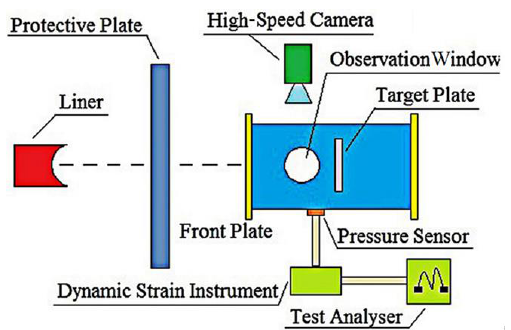
Figure 9. Schematic diagram of the energy-acquisition system.